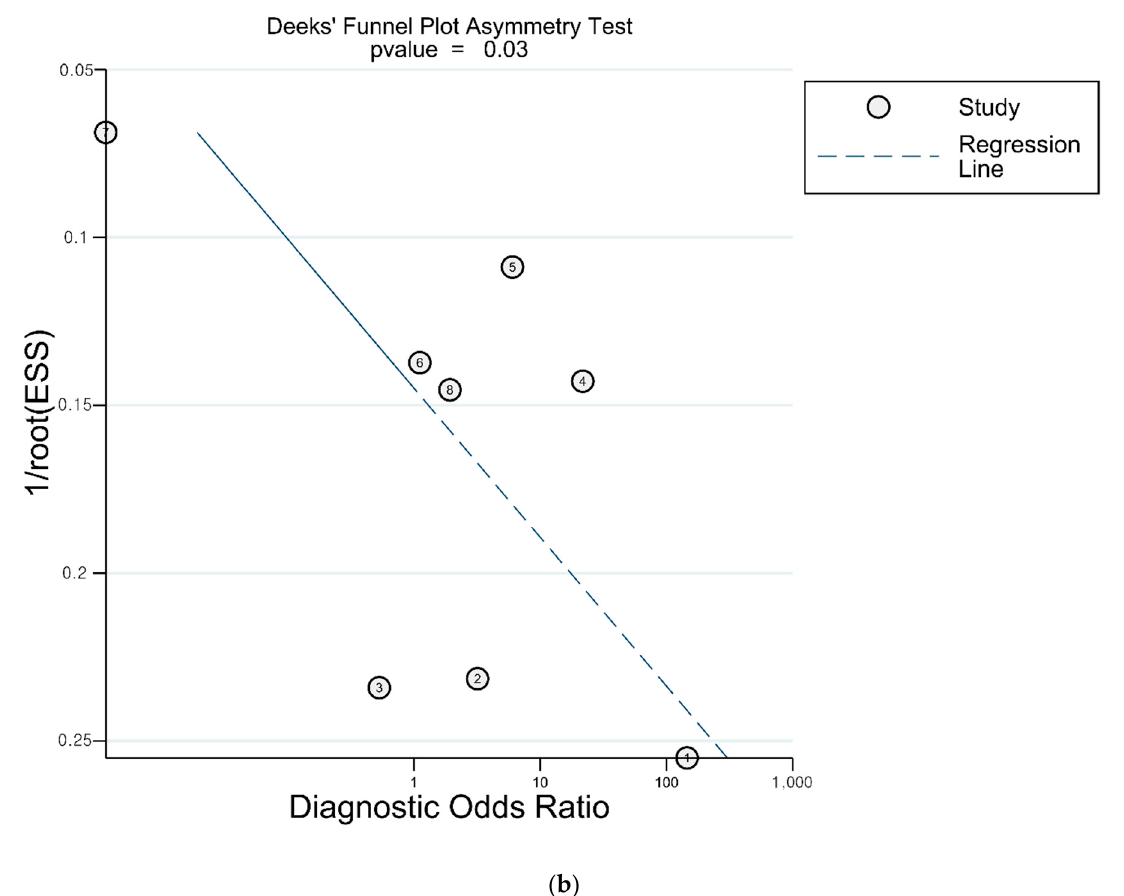
Figure 7. Asymmetry test for publications bias. ( a ) The diagnostic test accuracy for possible shock ( b ) and the diagnostic test accuracy for mortality.